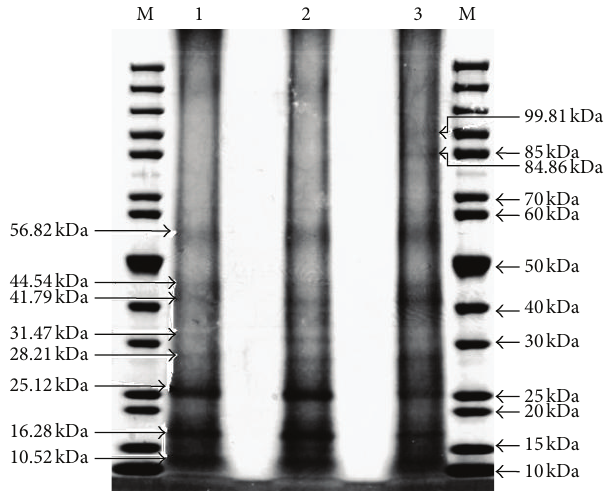
Figure 7: Total protein profile of florets (1:100% mantled, 2:50% mantled, 3: Phenotypically normal, and M:PageRuler Unstained Protein Ladder).